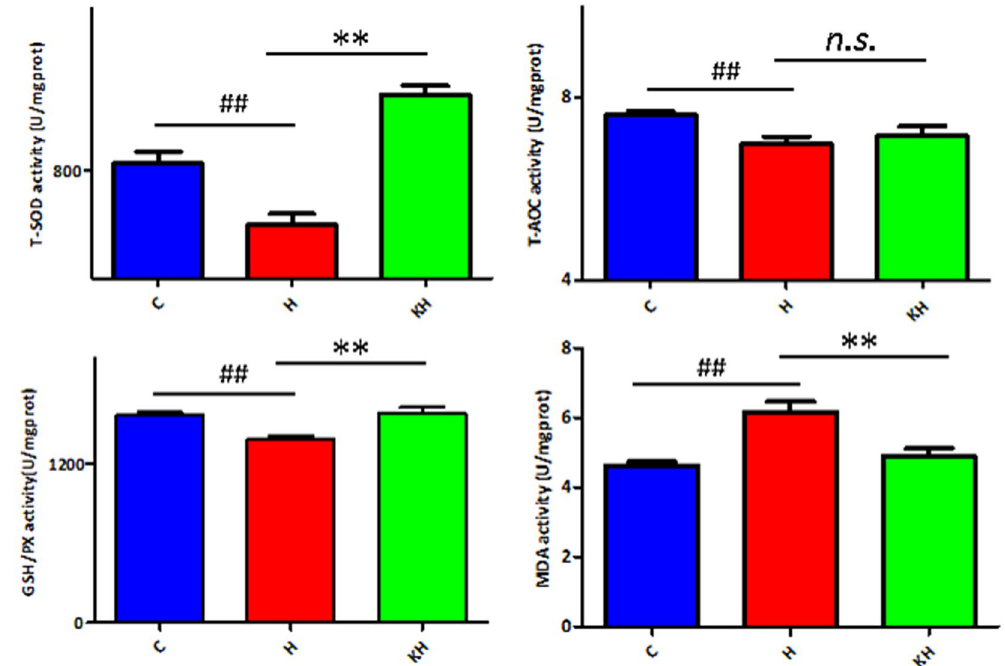
Figure 3. Effects of Kisspeptin on biochemical parameters of liver tissue. Date are expressed as mean ± SD (n = 6). ## Indicates p < 0.01 compared to the C group; ** Indicates p < 0.01 compared to the H group. C: control group; H: Heat stress group; KH group: Kisspeptin + Heat stress group.